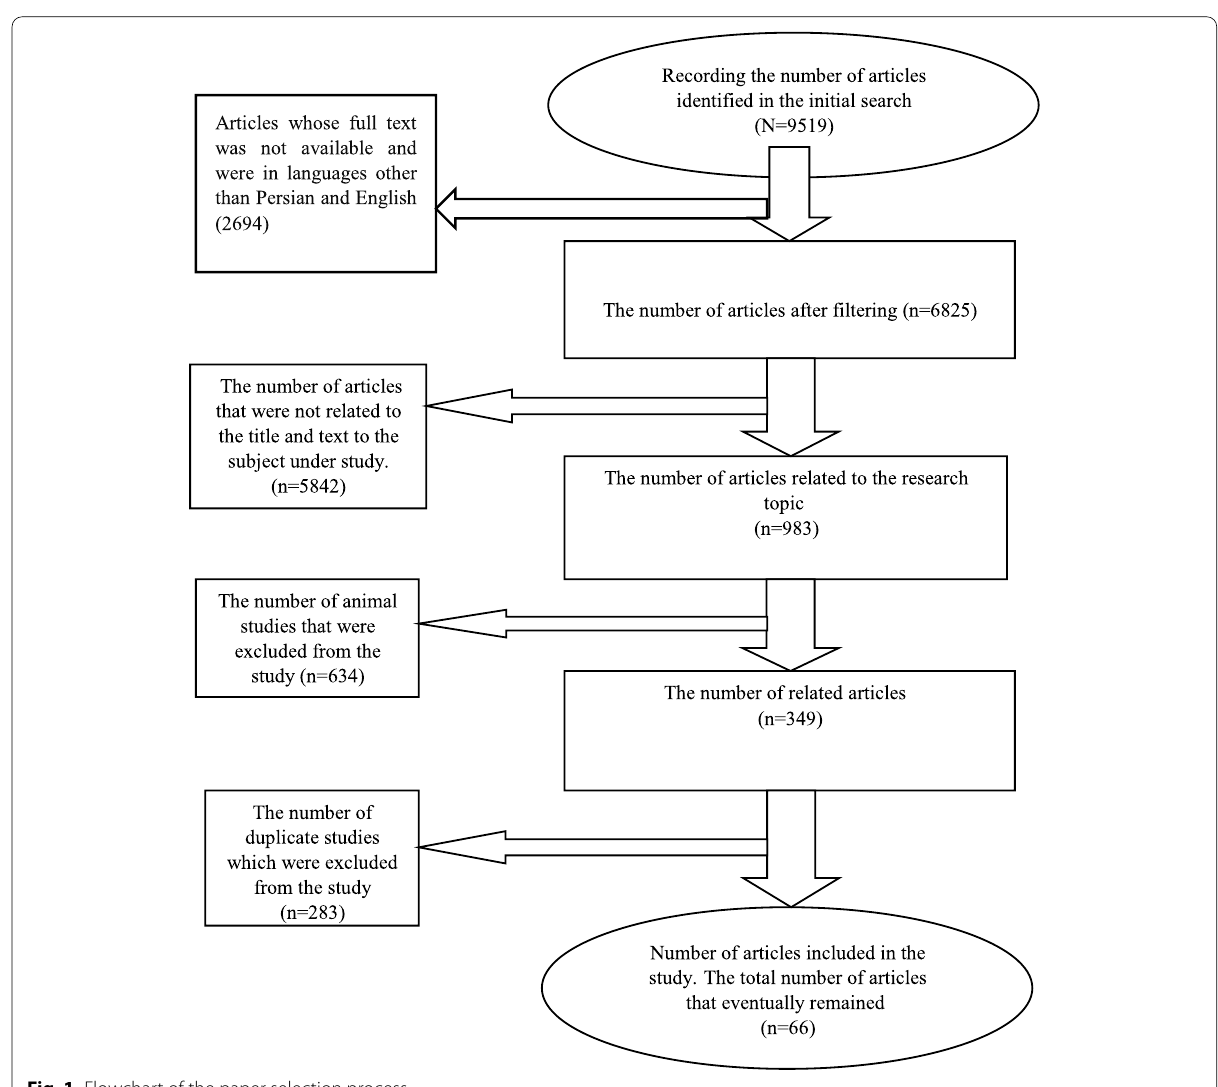
Fig. 1 Flowchart of the paper selection